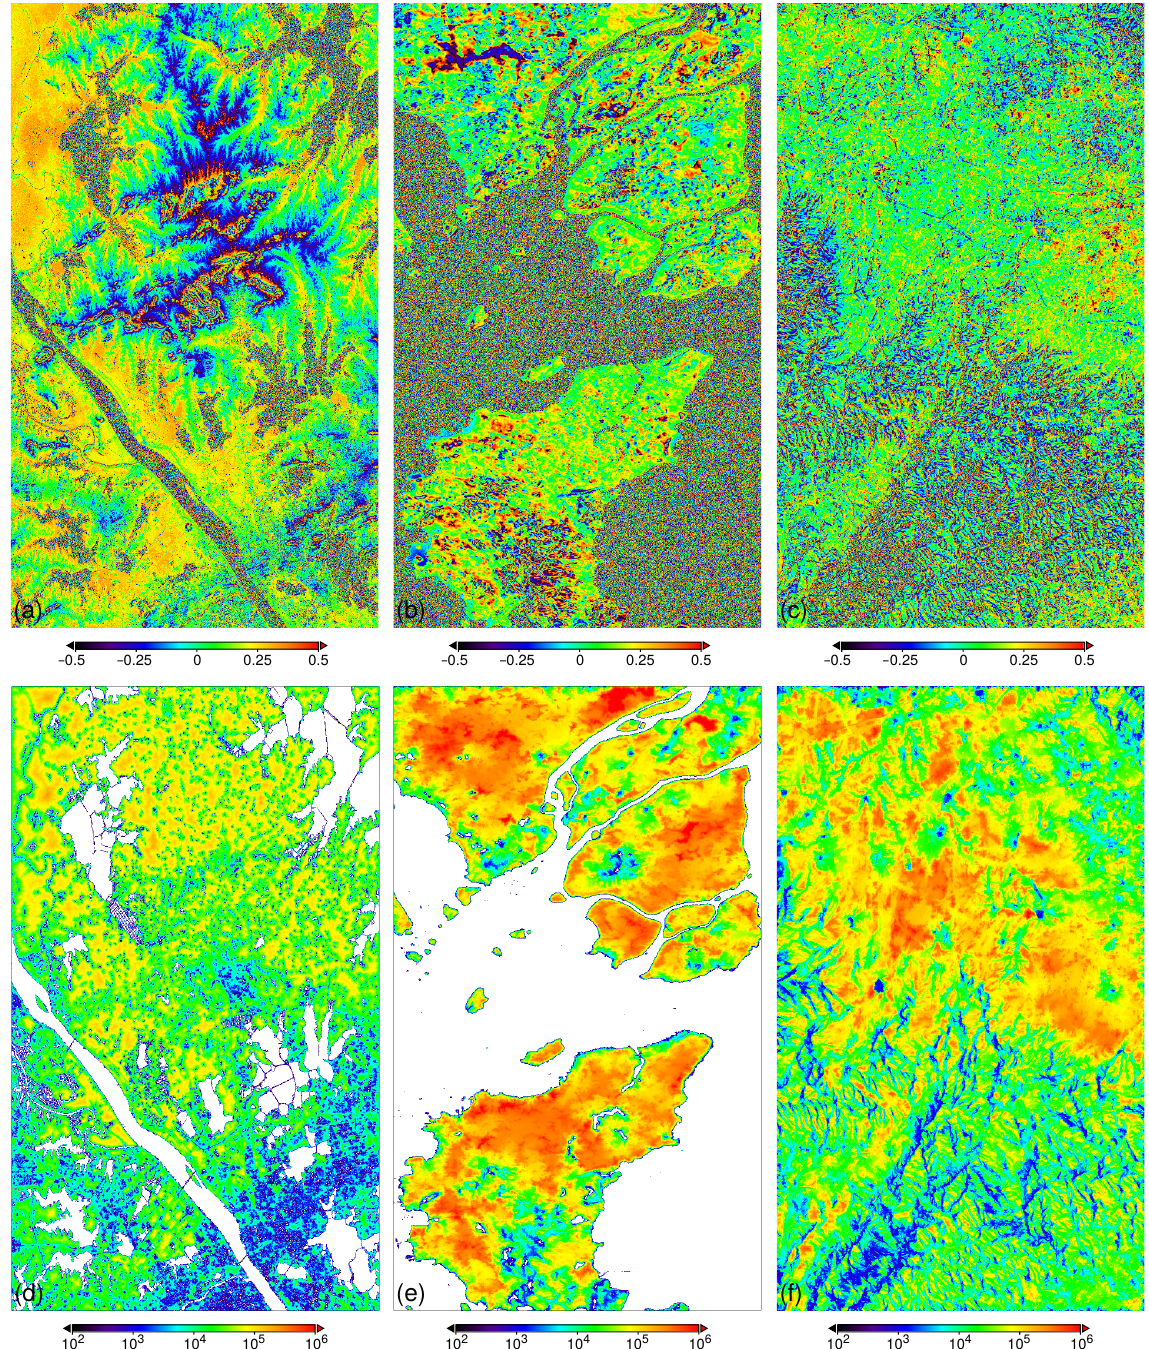
Figure 9. The wrapped phases (number of 2 π ) from Wuhan ( a ), Singapore ( b ), and Songshan ( c ) and their phase distance maps ( d – f ) after four times of residue coupling, respectively. The water areas in ( d , e ) are